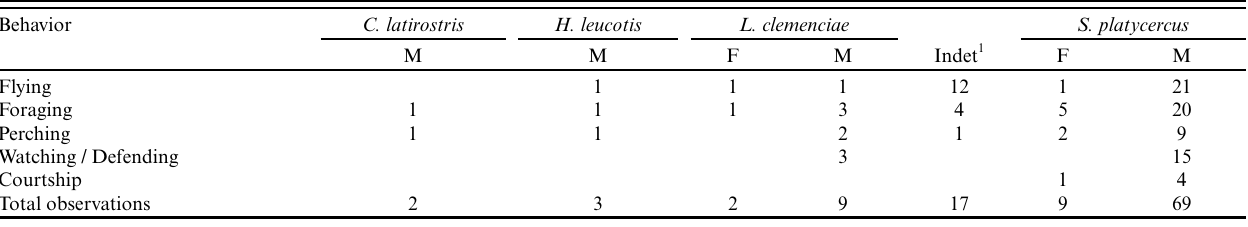
Table 2 . Behavioral observations of four hummingbird species studied at four volcanoes of the Transmexican Volcanic Belt in 2014– 2017. Values indicate the number of times individuals of each species were observed performing one of the six listed behaviors.